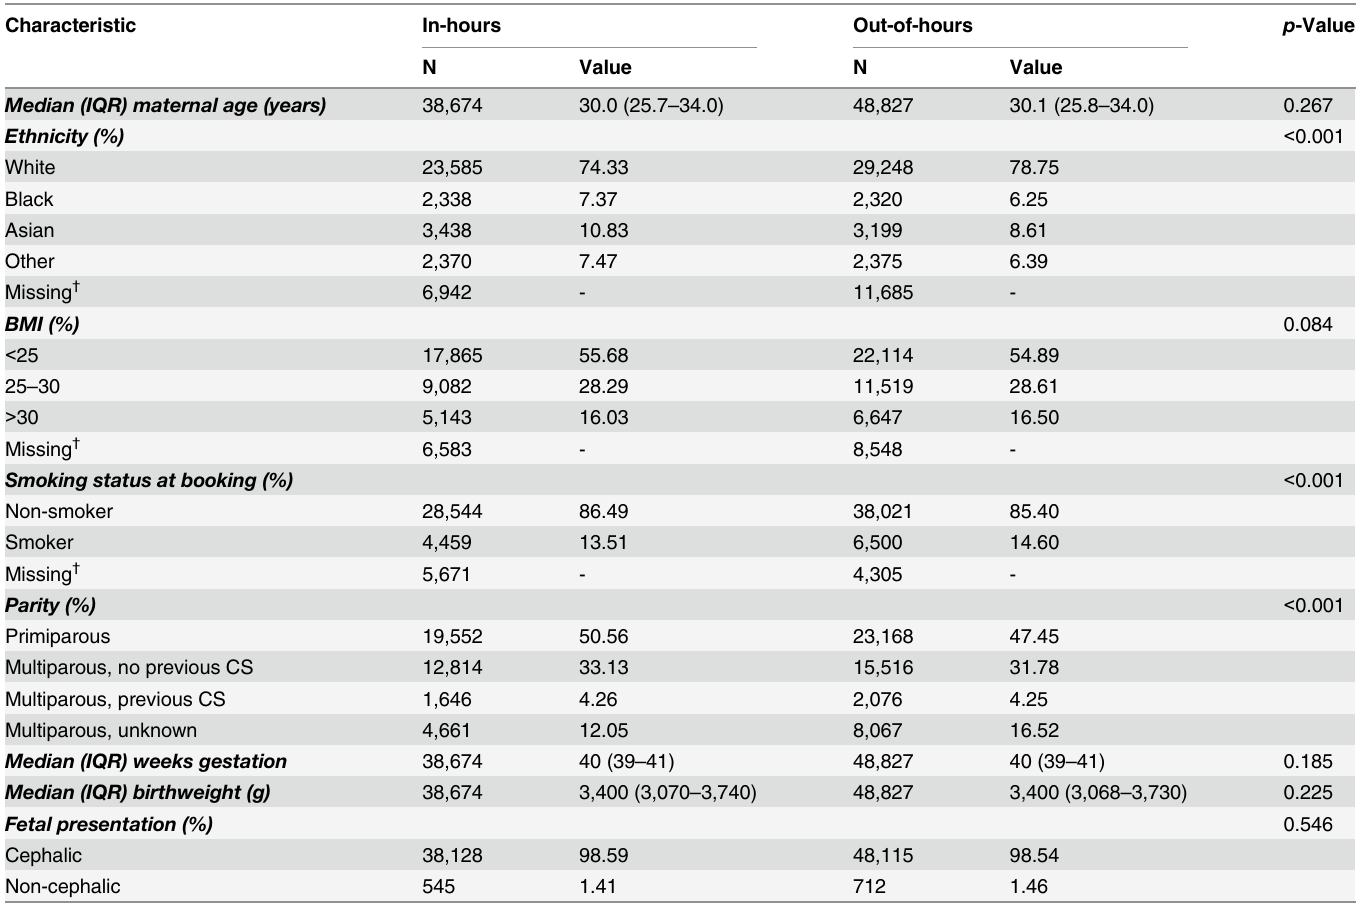
Table 1. Characteristics of the cohort, comparing in-hours with